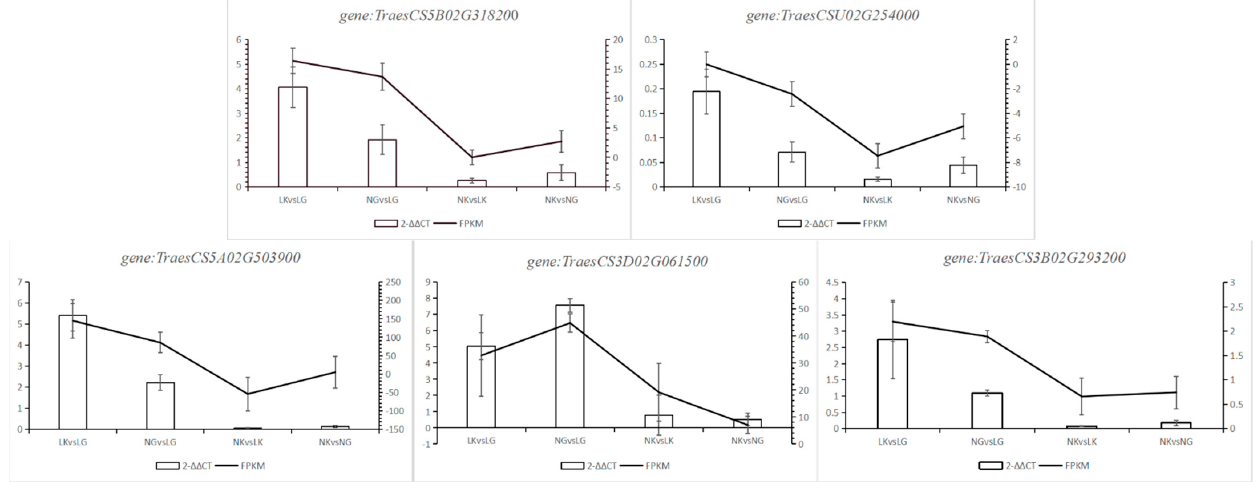
Figure 6. RT − qPCR Verification